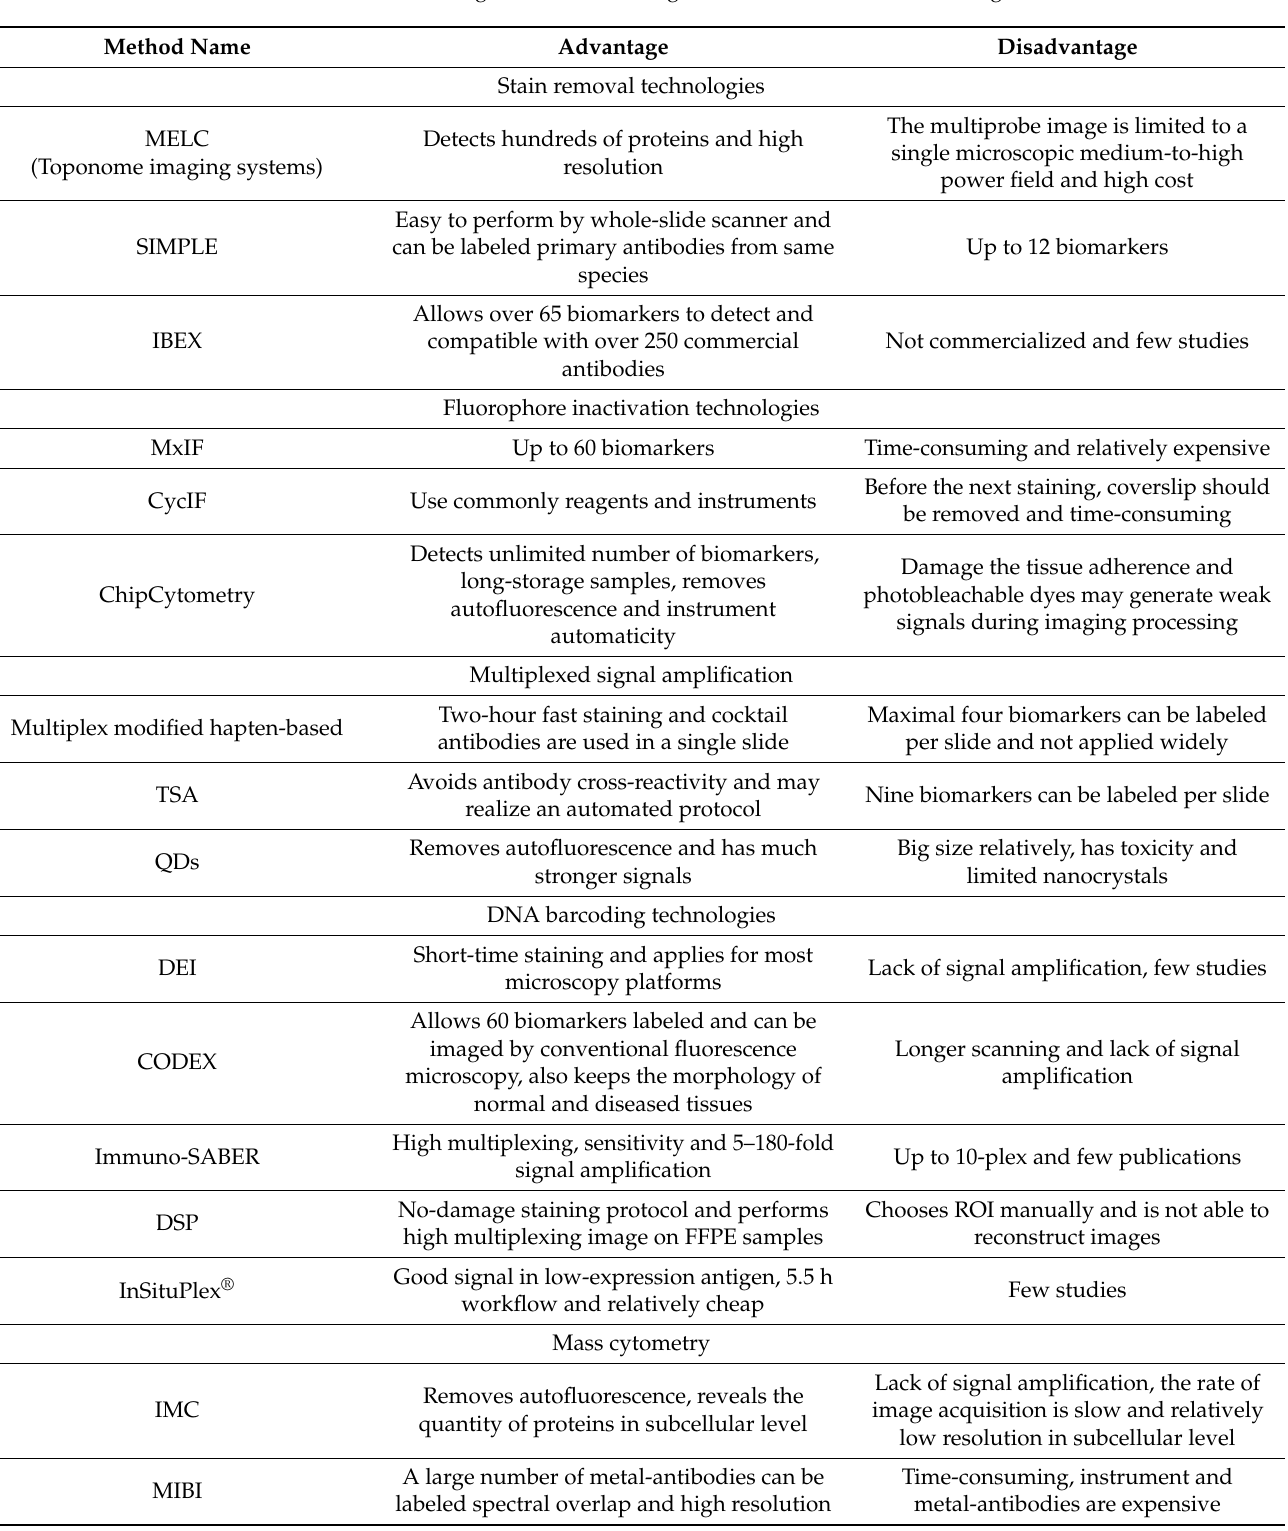
Table 3. Advantages and disadvantages for different mfIHC